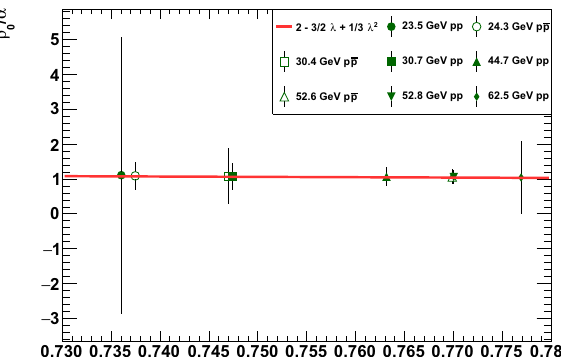
Fig. 32 The dependence of ρ 0 /α on λ in the few tens of GeV energy range. Filled and empty symbols correspond to the pp and p ¯ p cases, respectively. These values and the error-bars for ρ/α are obtained from theReBBmodelfitsbyusingtheexcitationfunctionsofthescaleparam- eters R q ( s ) , R d ( s ) , R qd ( s ) , shown in Fig. 30a–c and summarized in Table 2, as well as the experimentally measured ratio ρ 0 values. The red curve represents the analytic result, corresponding to Eq. (B.7) in Appendix B, showing a good agreement between the analytic consid- erations and the numerical results